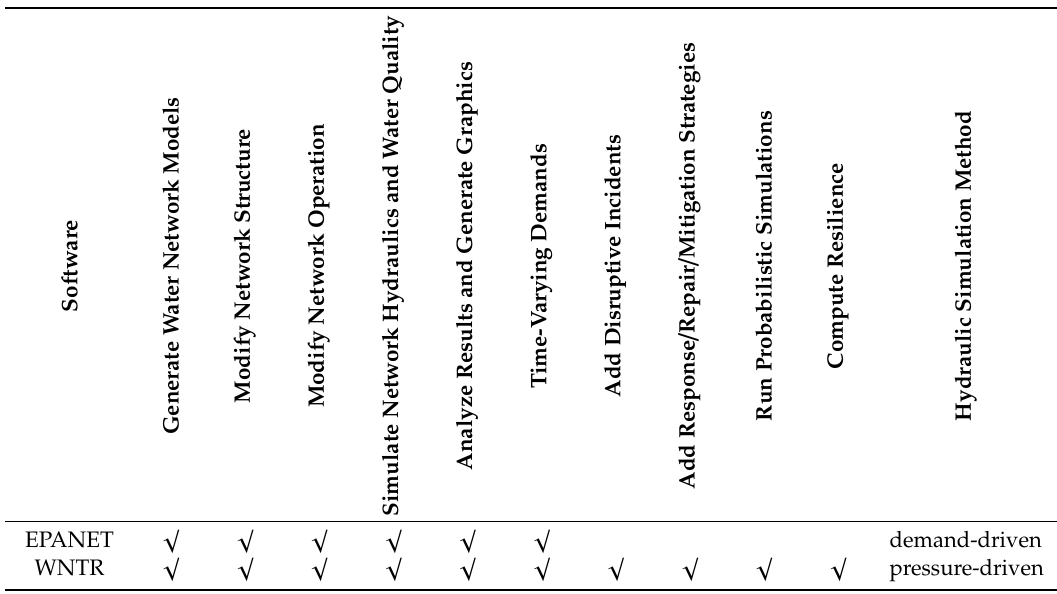
Table 1. Comparison of EPANET and WNTR